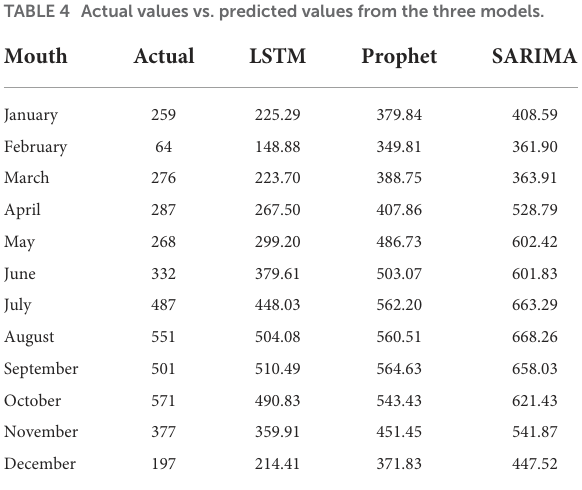
TABLE 4 Actual values vs. predicted values from the three models. Mouth Actual